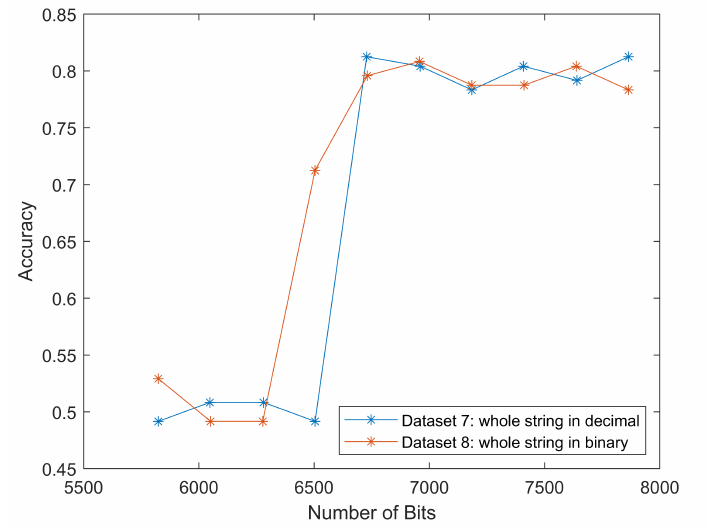
Figure 10. Classification accuracies for different length of whole string in decimal or binary form. The tread of two curves proves the whole string in both decimal and binary form can be classified.